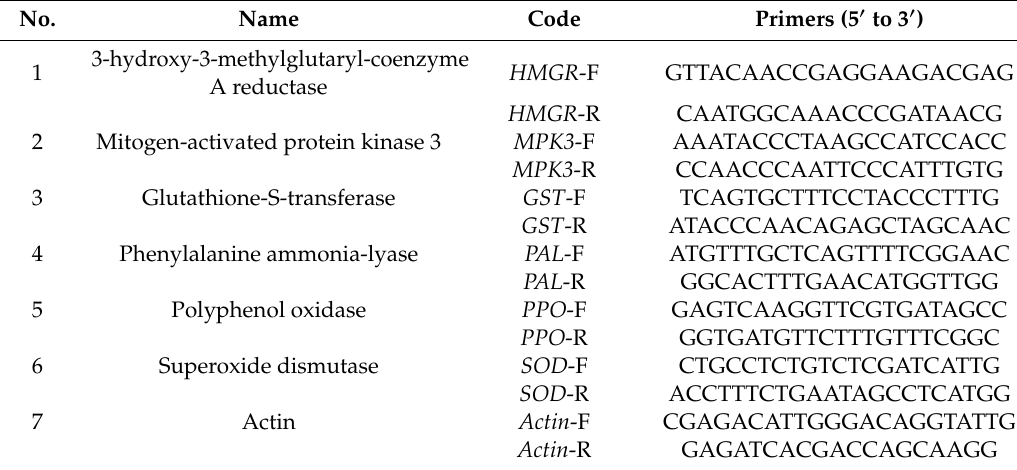
Table 3. Oligonucleotides used in this study for qRT-PCR analysis. No. Name